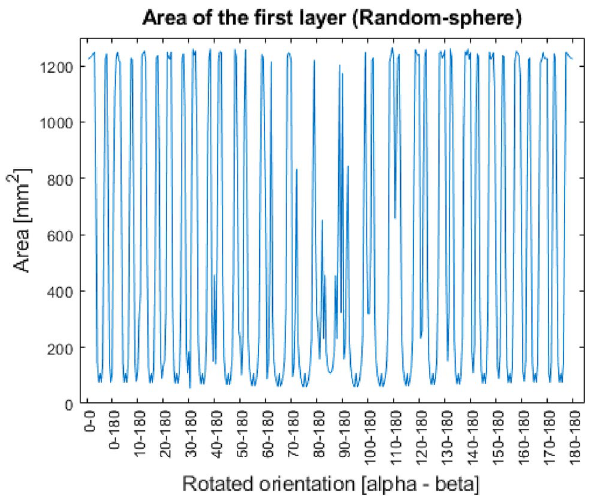
Figure 12. Area of the first layer (special